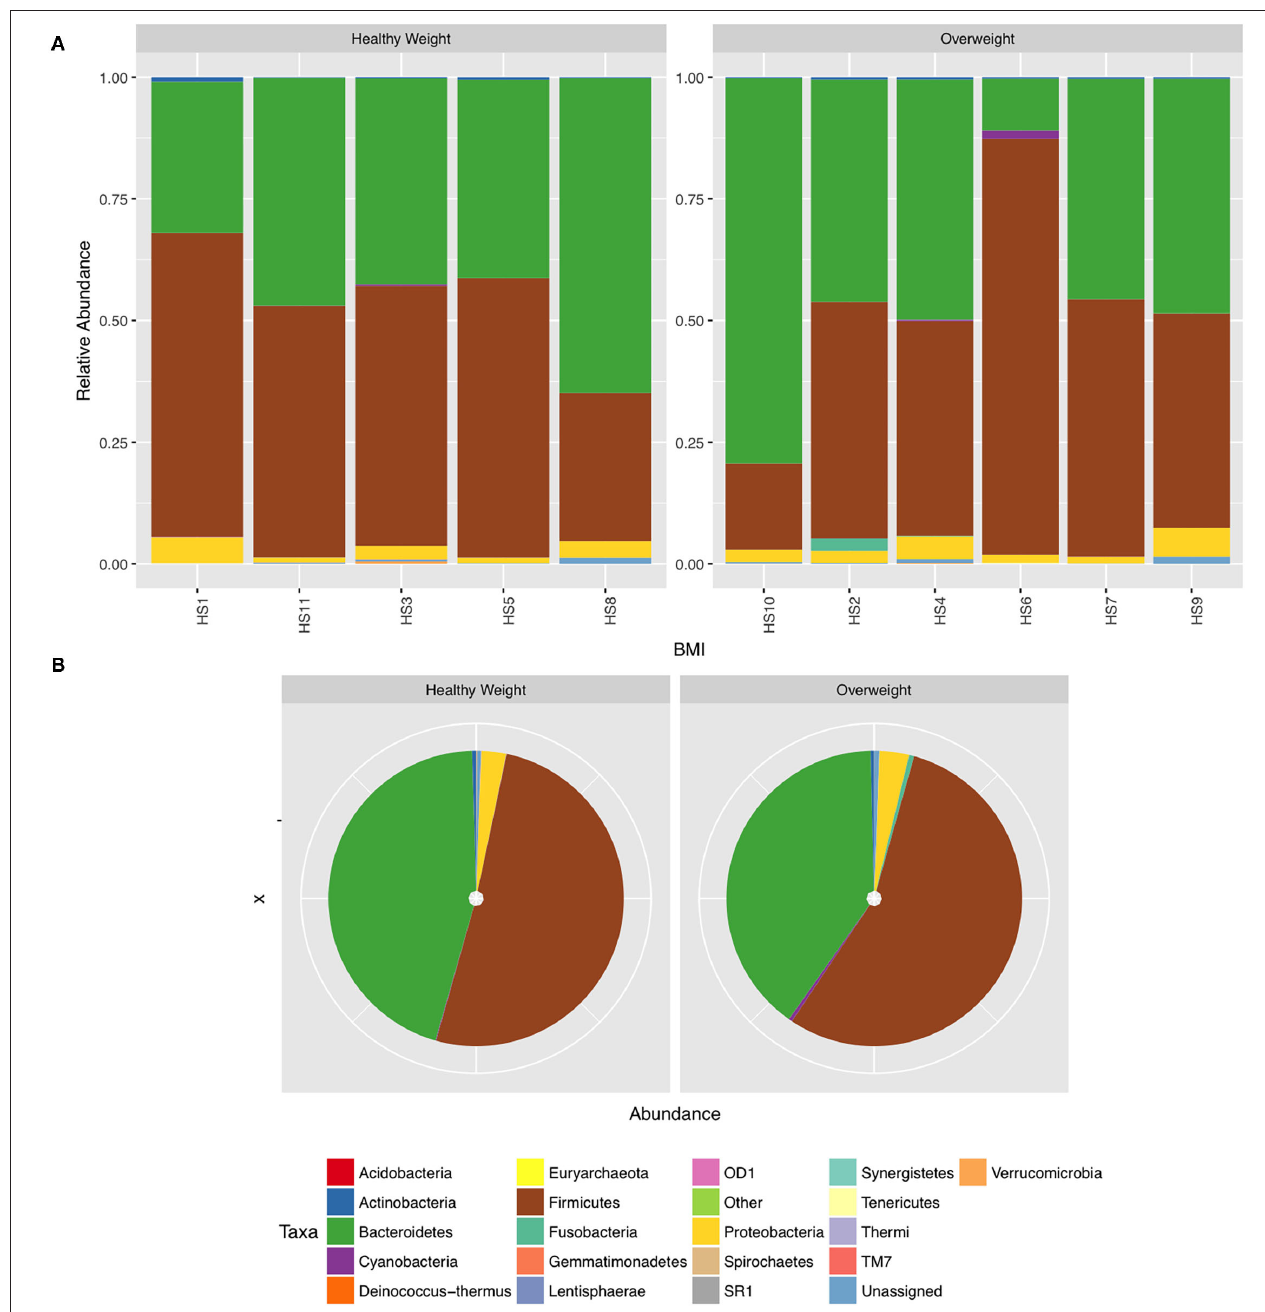
FIGURE 1 | Relative abundance at phylum level for healthy samples stratified by body mass index (BMI). (A) Individual subject stacked bar charts. (B) Collective pie chart representation.